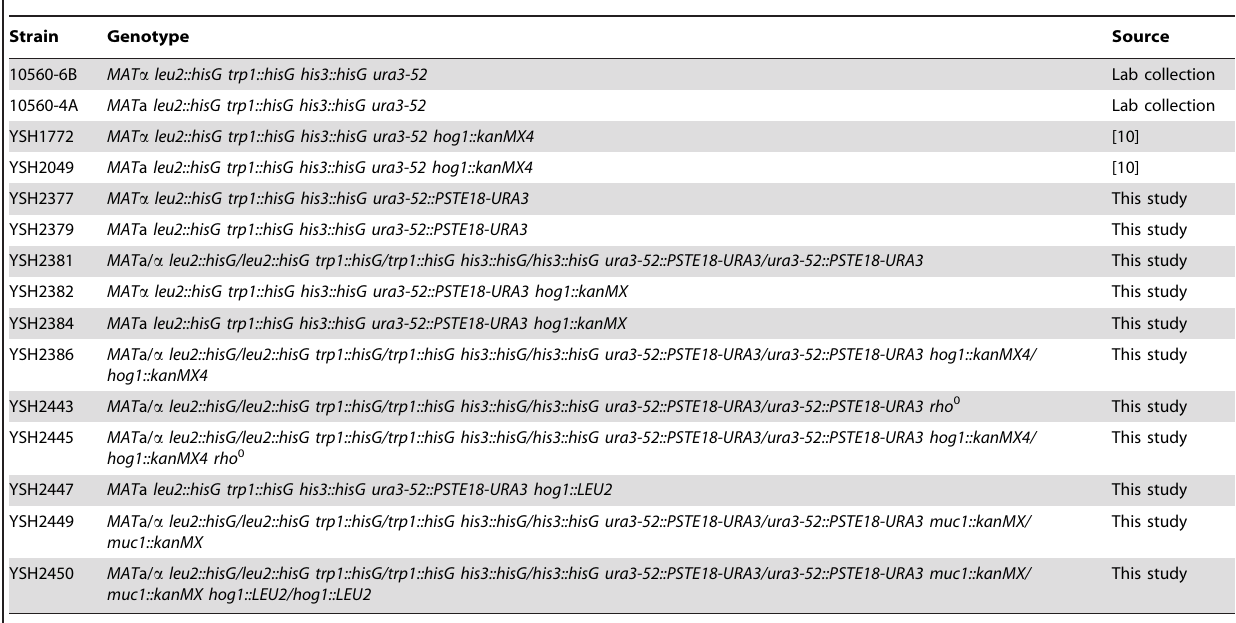
Table 2. Yeast strains used in this